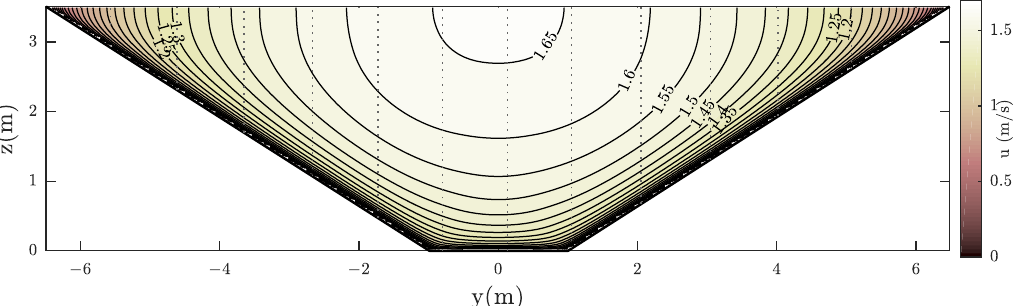
Figure 4. Hydraulic model results for measurement 3b in section GG11. The position of the measured verticals is indicated by a grey dashed